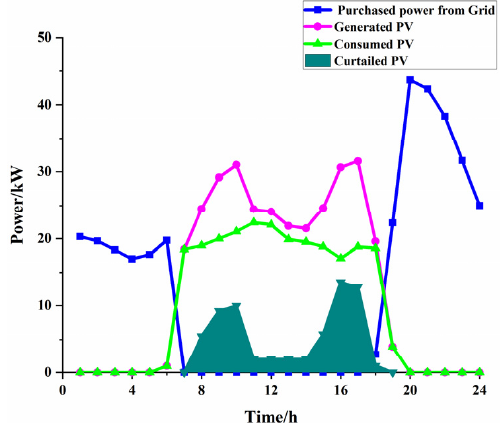
Figure 11. The power balance of the conventional PDN.